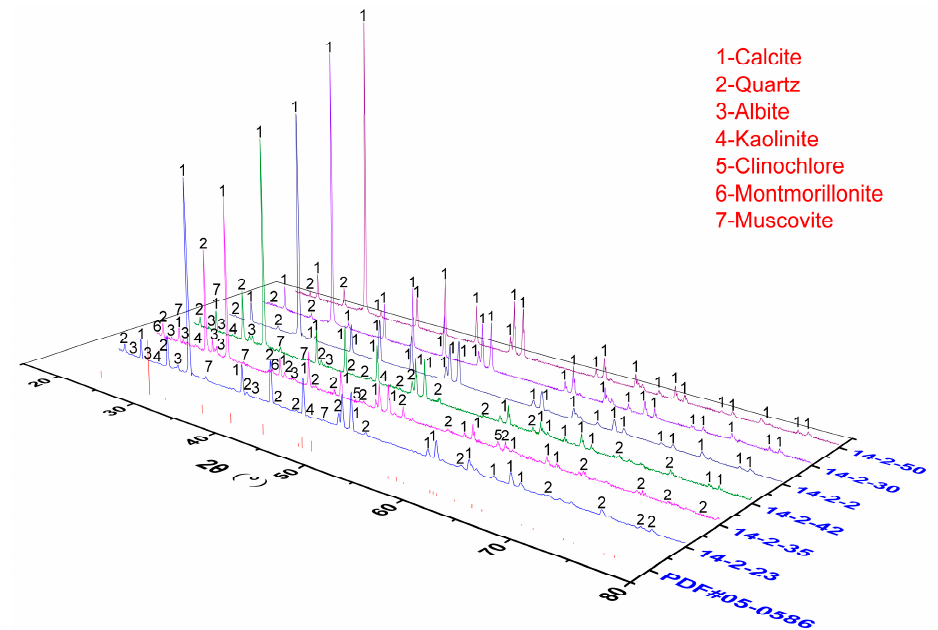
Figure 3. XRD patterns of calcareous tufa profile in Sparkling Lake. Table 1. Mineral percentage of calcareous tufa profile in Sparkling Lake.